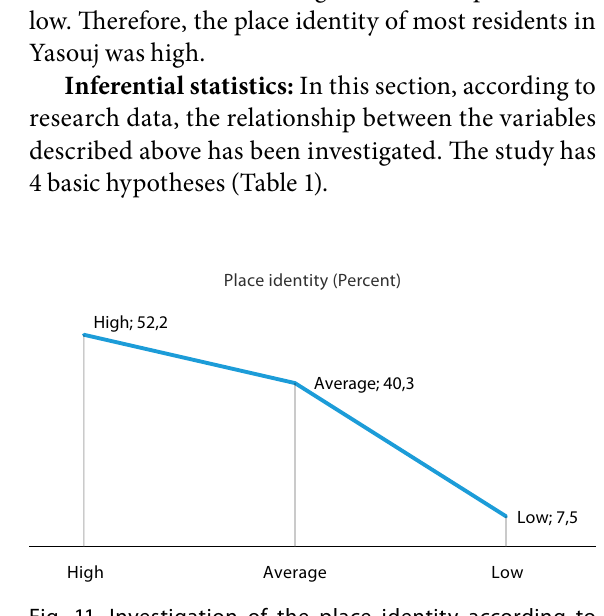
fig. 10. Yasouj plan area (created by the authors) fig. 11. Investigation of the place identity according to participants’ opinion in